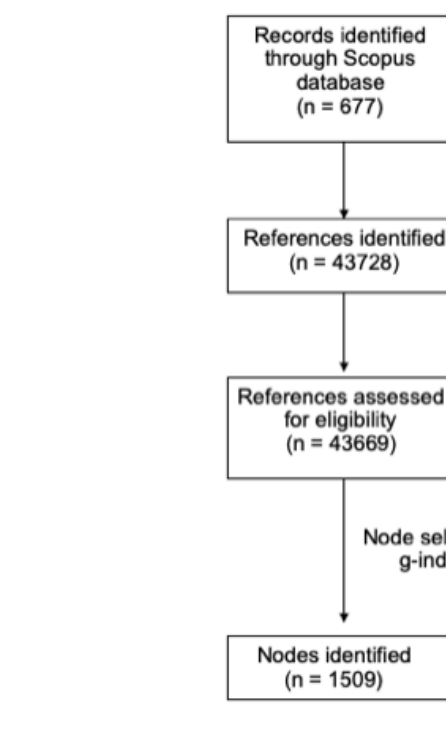
Figure 1. Study flow